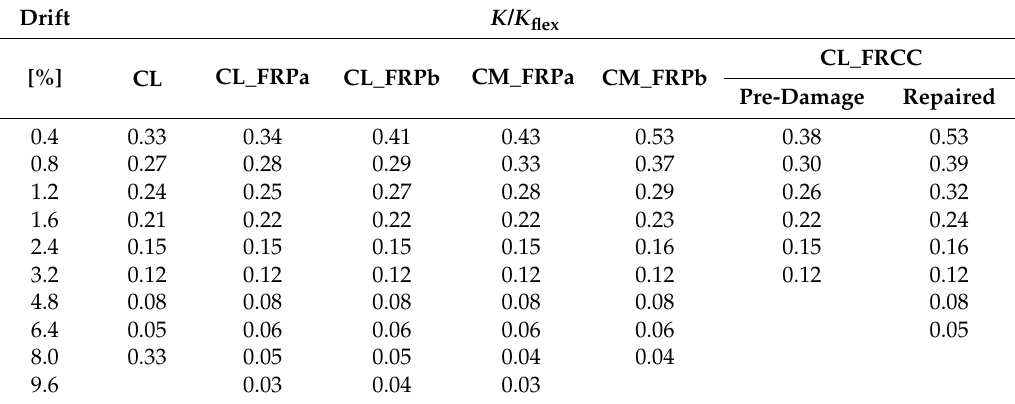
Table 3. Stiffness